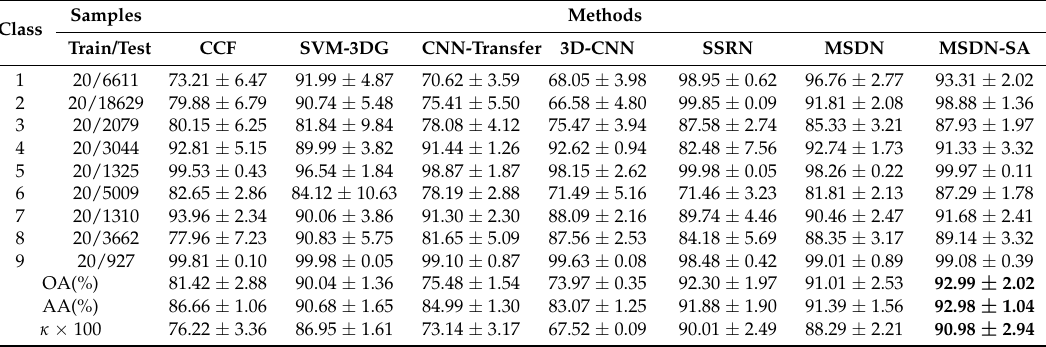
Table 3. Network architecture details of proposed MSDN-SA for University of Pavia Dataset.